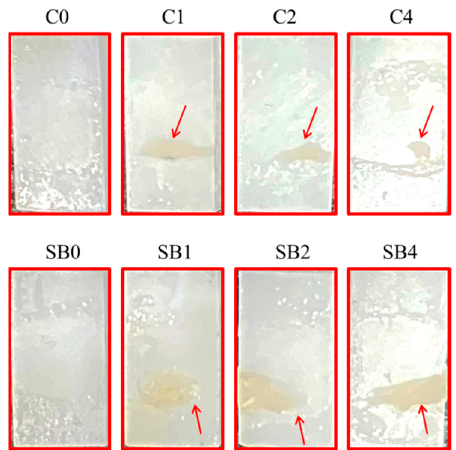
Figure 8. Fracture images of various Group C and Group SB specimens after shear bond testing. The arrow indicates the remained resin.